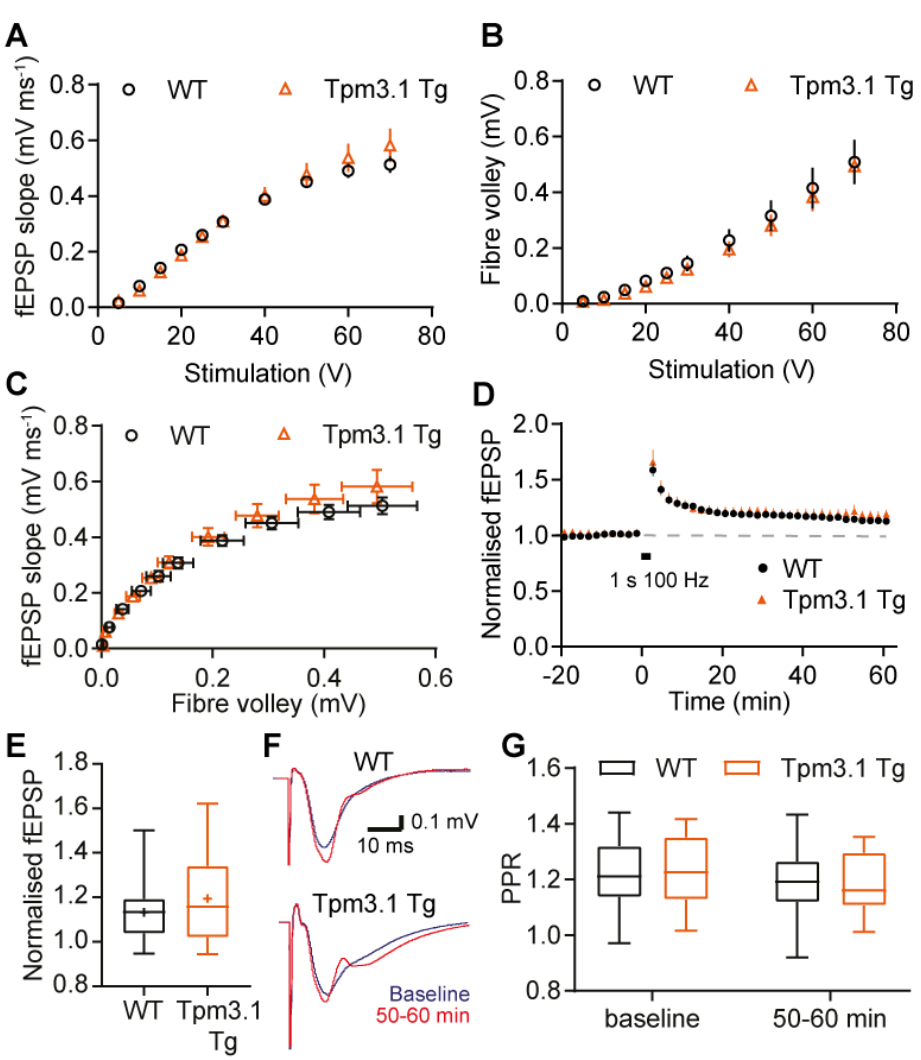
Figure 6. Tpm3.1 overexpression in acute hippocampal slices. ( A ) Input–output curve of maximum fEPSP slope plotted against stimulation voltage. ( B ) Input–output curve of fibre volley plotted against stimulation voltage. ( C ) fEPSP slope plotted against fibre volley to show synaptic efficacy. WT n = 30 slices from 20 mice, Tpm3.1 Tg n = 29 slices from 16 mice. ( D ) Plot of fEPSP over course of experiment, with each point representing the average from 2 min of recording. ( E ) Average normalised fEPSP from the last 10 min of recording after inducing LTP. ( F ) Example waveforms from baseline (blue), and last 10 min of recording (red). ( G ) PPR at baseline and last 10 min after HFS. WT n = 21 slices from 17 mice, Tpm3.1 Tg n = 19 slices from 14 mice. WT values are shown in black, Tpm3.1 Tg values shown in